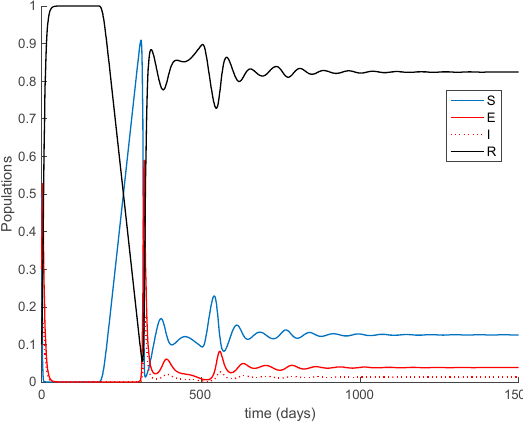
Figure 10. Sequences of populations for Case 1.6 conditions.